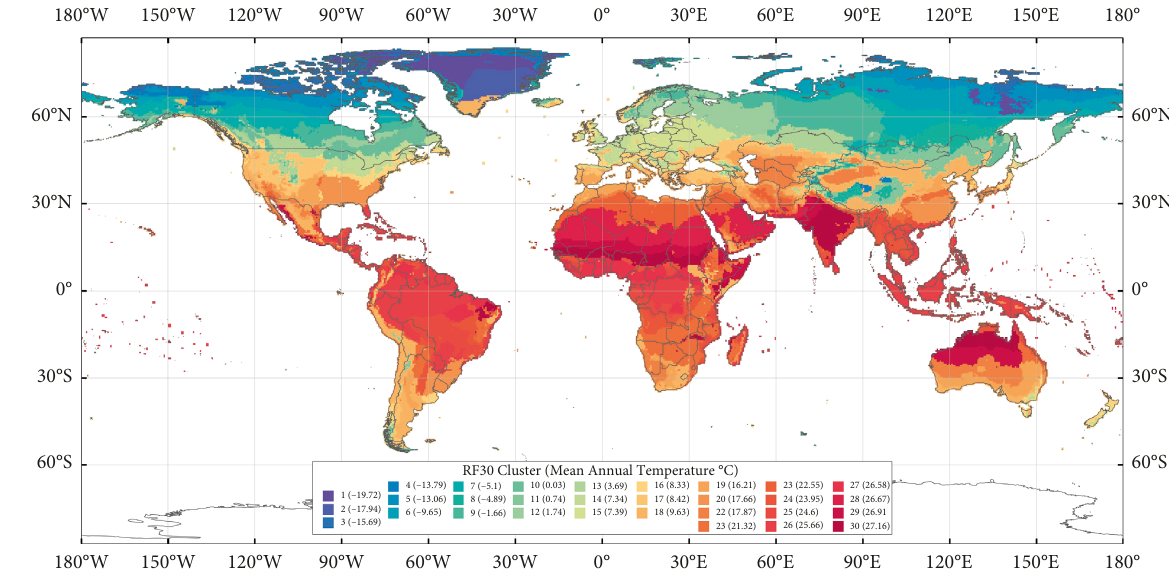
Figure 9: 30-cluster solution (RF30) of random forest clustering.